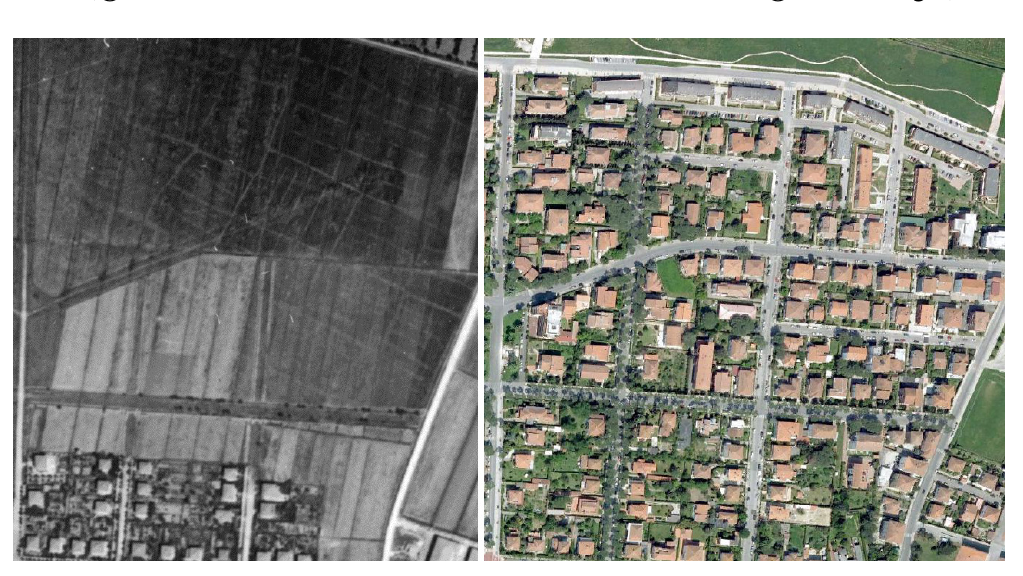
Figure 17. Visible crop marks from Roman times ( Left ) that reveal some agricultural divisions (canals or field boundaries) and modern constructions ( Right ) that cover the